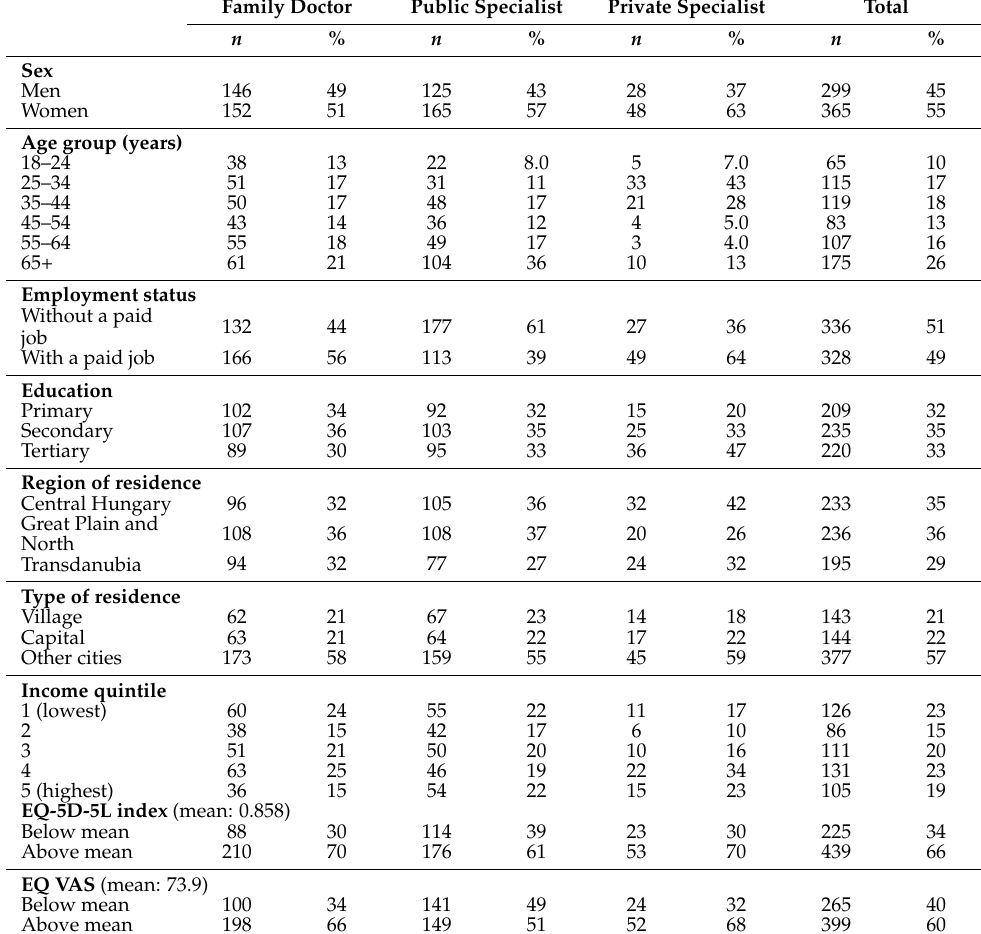
Table 1. Sociodemographic characteristics of the sample by type of provider.